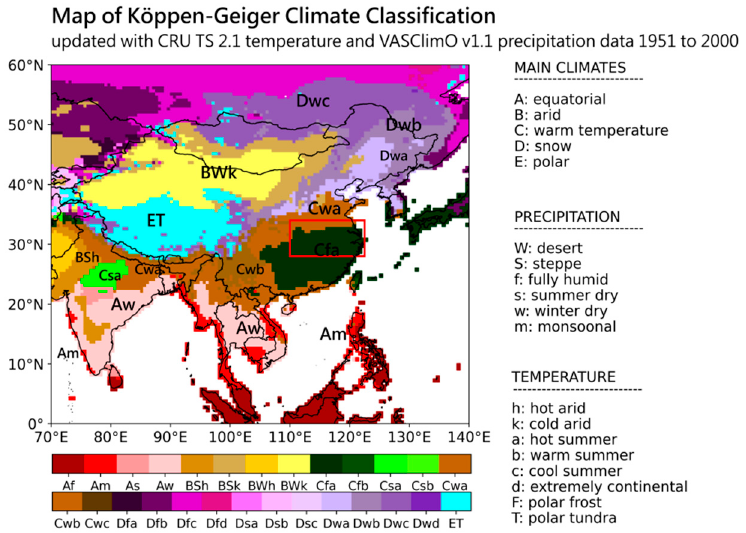
Figure 1. The Köppen-Geiger climate map. The area circled in red is the Meiyu monitoring area of this study.